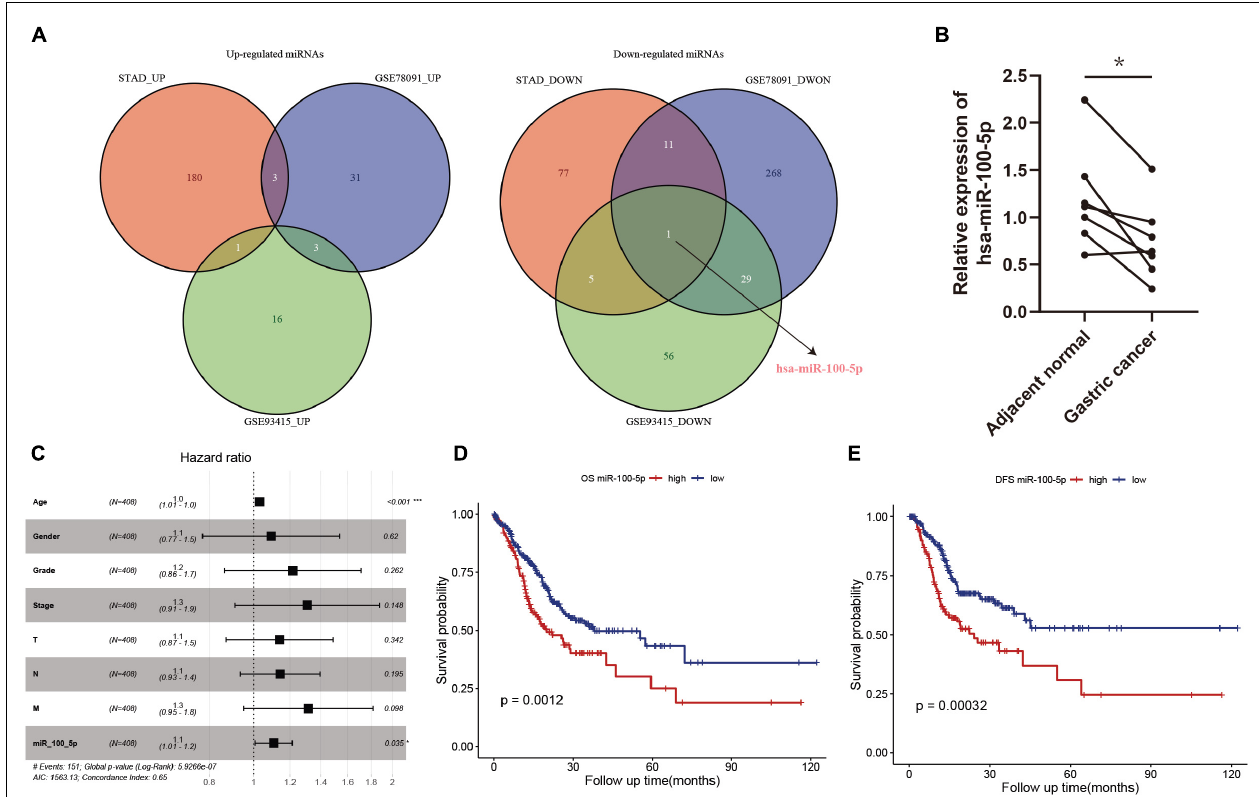
FIGURE 2 | The abnormal expression and prognostic value of hsa-miR-100-5p in stomach adenocarcinoma (STAD). (A) Venn diagrams of differentially expressed miRNAs. (B) The relative expression level of hsa-miR-100-5p was downregulated in gastric cancer compared with adjacent normal tissues. (C) Multivariate Cox analysis of miR-100-5p and clinical features. (D,E) Kaplan–Meier survival analyses of miR-100-5p in STAD patients on overall survival (D) and disease-free survival (E) . * p < 0.05; *** p < 0.001.